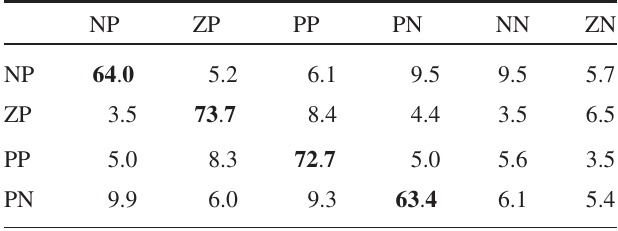
TABLE III. Frequency (in percentage) of the chosen function type (NP, ZP, PP, PN, NN, or ZN) in the answer as function of the function type (NP, ZP, PP, and PN) in the question from all 385 respondents. Correct answers are in bold